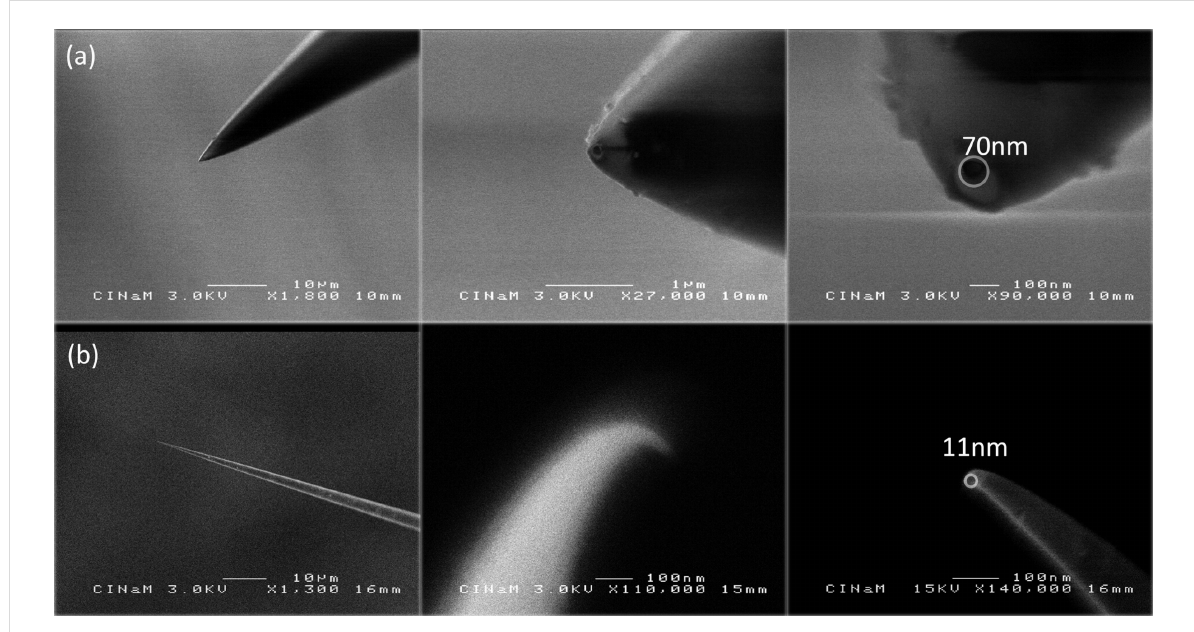
Figure 1: Upper line (a): three SEM images of the same nanopipette filled by applying high back-pressure; lower line (b): three SEM views of a capil- lary impossible to fill by applying high back-pressure (see fabrication program 2, Experimental section). It is very thin, elongated and bent at its tip with a hole of d tip = 11